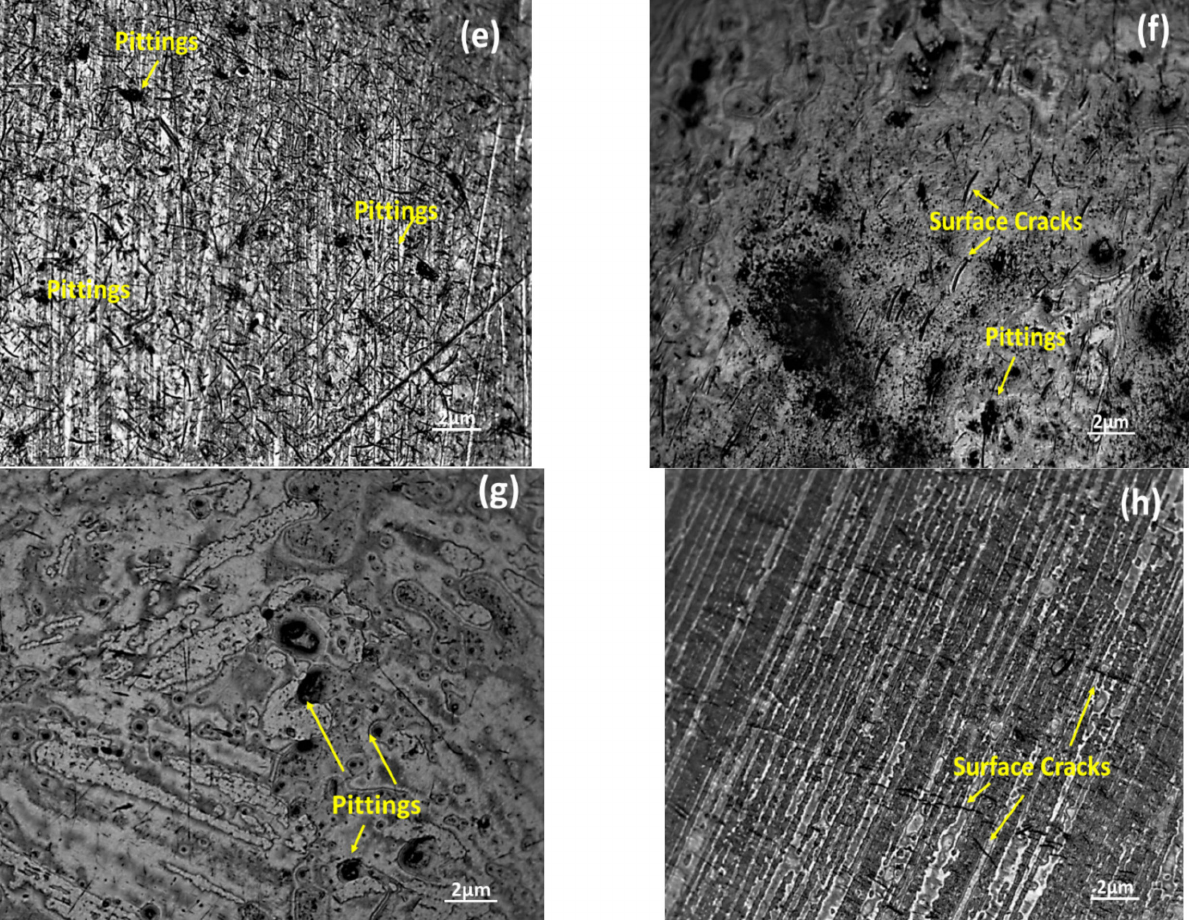
Figure 8. Optical microscope images of steel balls after rolling contact fatigue test: ( a , b ) MO; ( c , d ) MO + 2% WS 2 ; ( e , f ) MO + 3% MoS 2 ; ( g , h ) MO + 3%